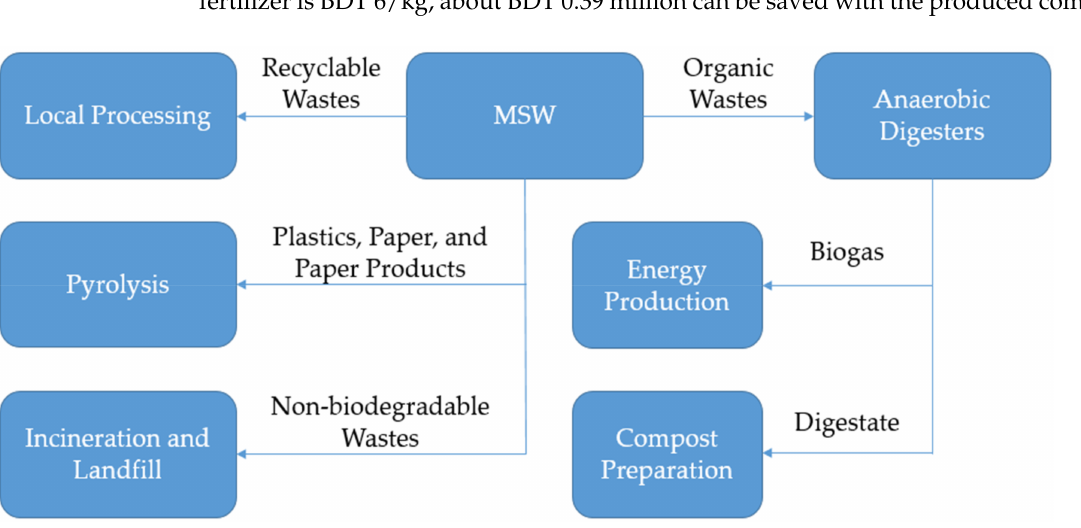
Figure 11. Proposed MSW management system in RCC. Table 10. Energy recovery potential from anaerobic digestion.